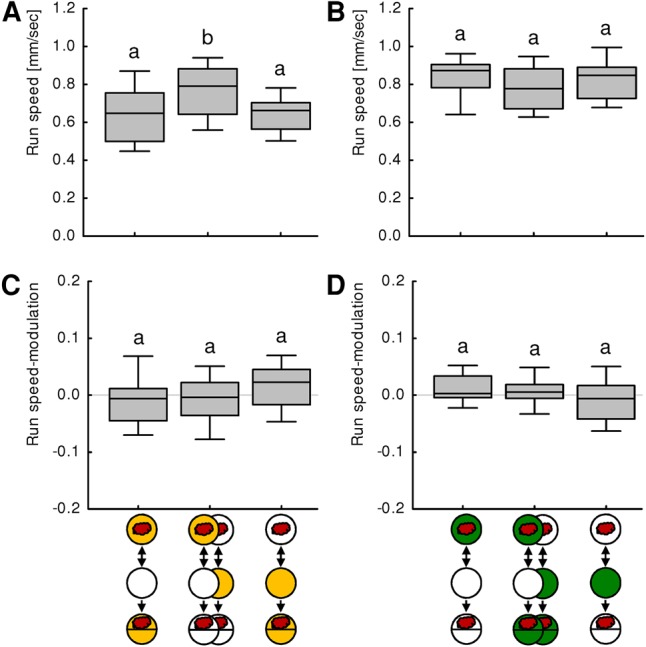
Analysis of run speed. (A,B) show run speed, (C,D) show run speed-modulation. (A) After aversive training, both reciprocally trained groups tested in the presence of quinine display lower run speed than the baseline, but do not differ from each other. (B) After appetitive training, the reciprocally trained groups tested on pure agarose display the same run speed, which is tendencially higher than under baseline conditions, i.e., in the presence of fructose. (C) After aversive training, there is no significant effect of training experience on run speed-modulation, and the pooled values of run speed-modulation are not different from zero (OSS, P > 0.05). That is, larvae do not modulate their run speed depending on their orientation to the odor. (D) After aversive training, there is no significant effect of training experience on run speed-modulation, and the pooled values of run speed-modulation are not different from zero (OSS, P > 0.05). Only with respect to run speed after aversive training did we find a significant difference across groups (P < 0.05, df = 2, N = 27, 56, 27, KW), which was, however, not associative in kind as both the reciprocally trained groups were affected. In all other cases, no significant difference across groups was detected (P > 0.05, df = 2, N = 27, 56, 27, KW). Significant between-group differences (MWU, P < 0.05 corrected according to Bonferroni–Holm) are indicated by lower case letters above the boxes.